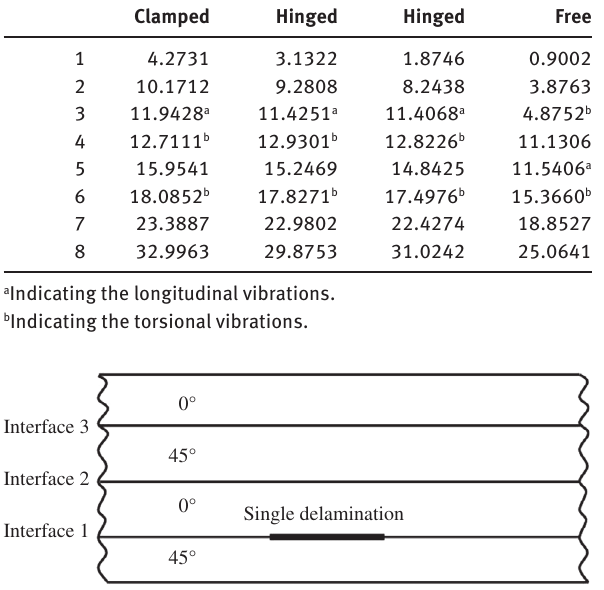
Table 8 Nondimensionalized free mode frequencies of symmetric angle-ply [10 ° /-10 ° /10 ° /-10 ° ] Mode no.